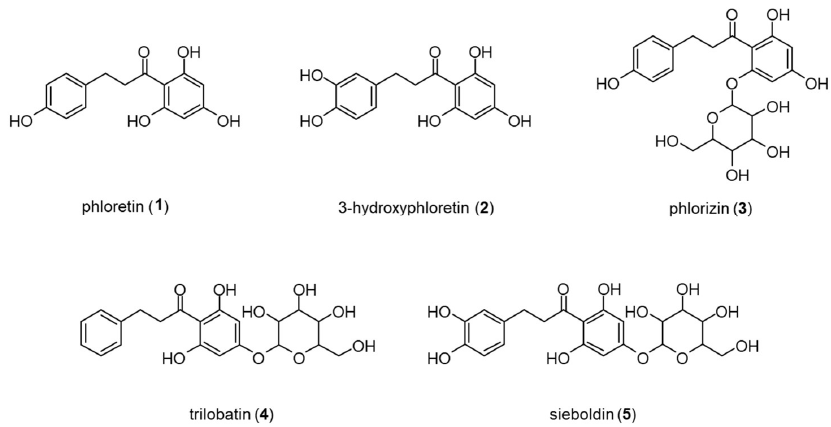
Figure 1. Structure of the investigated